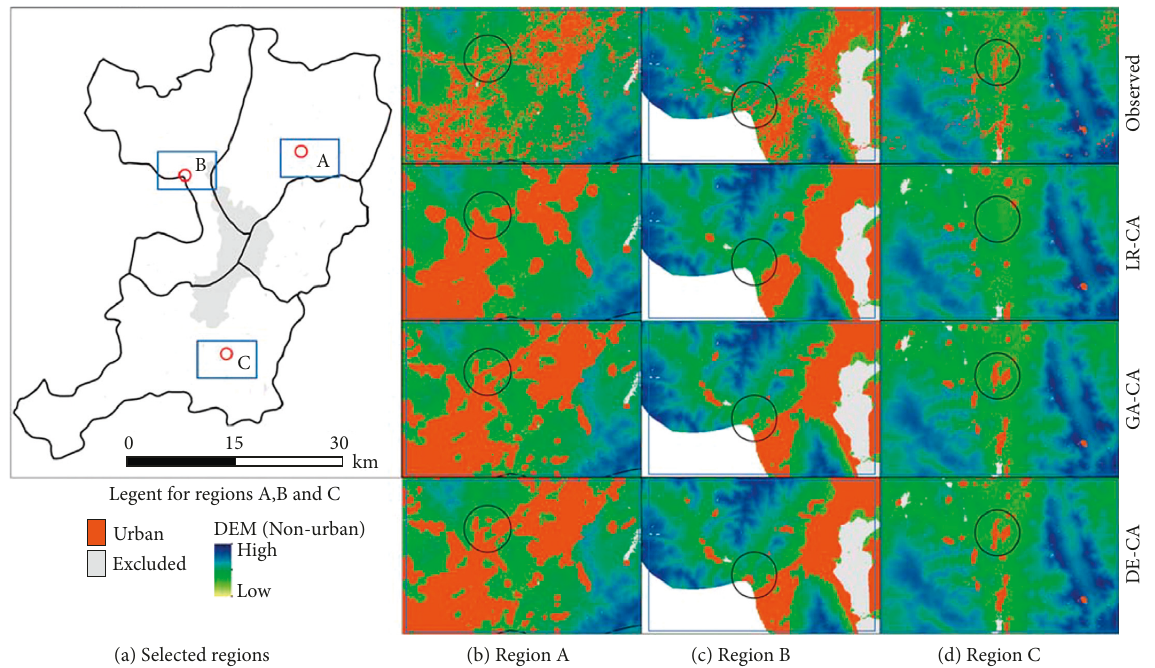
Figure 6: Comparison between two different approaches to growth with what was observed in Guangzhou (China), 2012. (a), (b), and (c) are overall results, and fusions of (d), (e), (f) and (g), (h), and (i) are zoomed-in viewpoints, respectively, of local areas A and B